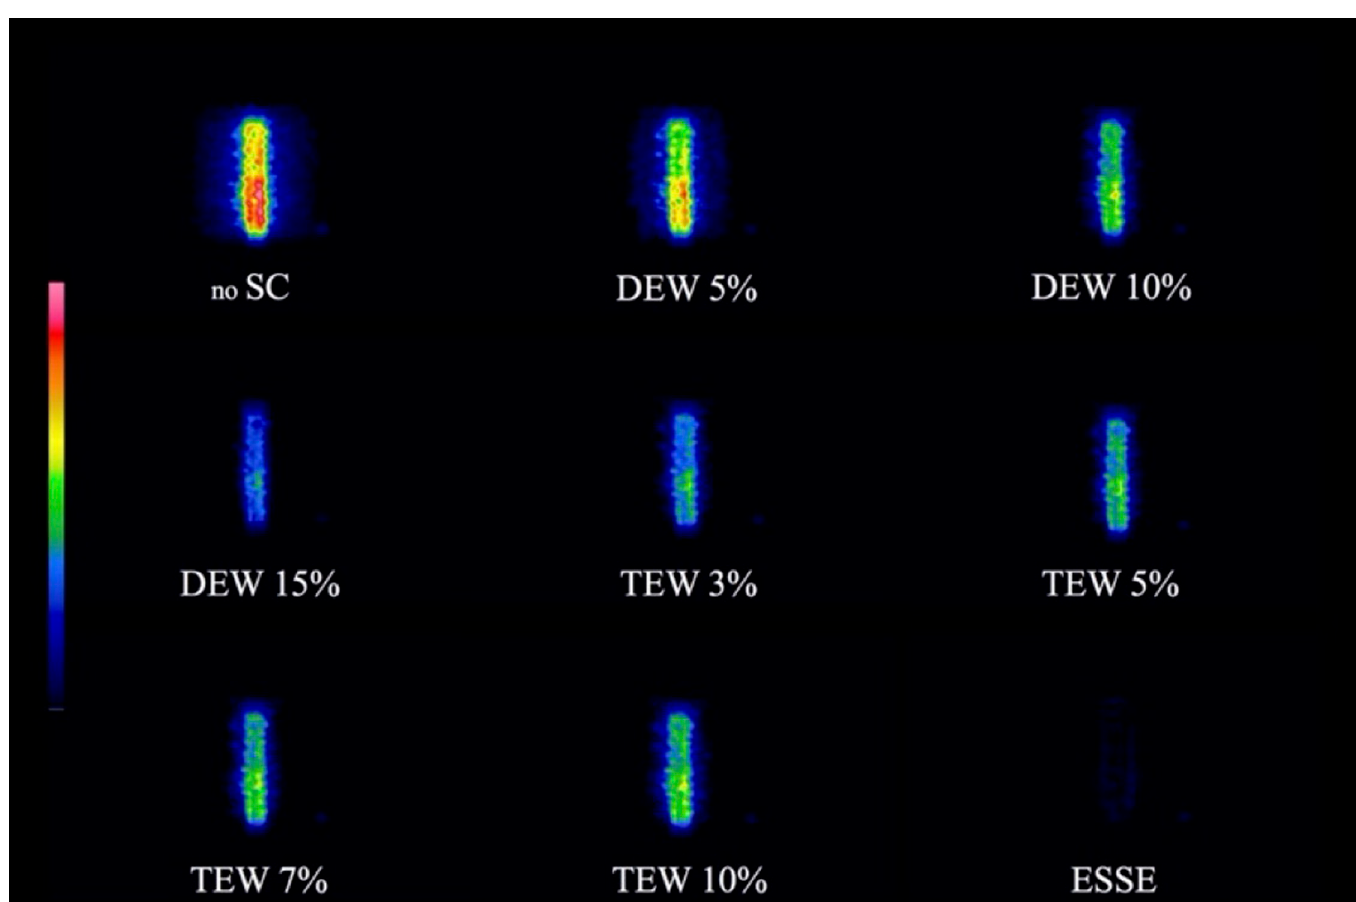
Fig 4. Images of scattered radiation after scatter correction. Increased red intensity indicates more residual scattered radiation. DEW, dual energy window; ESSE, effective scatter source estimation; SC, scatter correction; TEW, triple energy window.